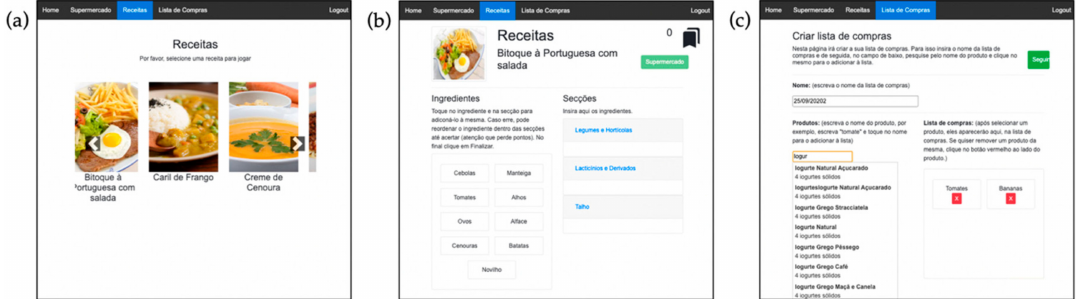
Figure 3. ( a ) View of the recipe game mode; ( b ) extra step of difficultly in the recipe game mode, in which users have to organize the ingredients (left side of the screen) under the corresponding category (right side of the screen); ( c ) view of the shopping list game mode with two products included in the